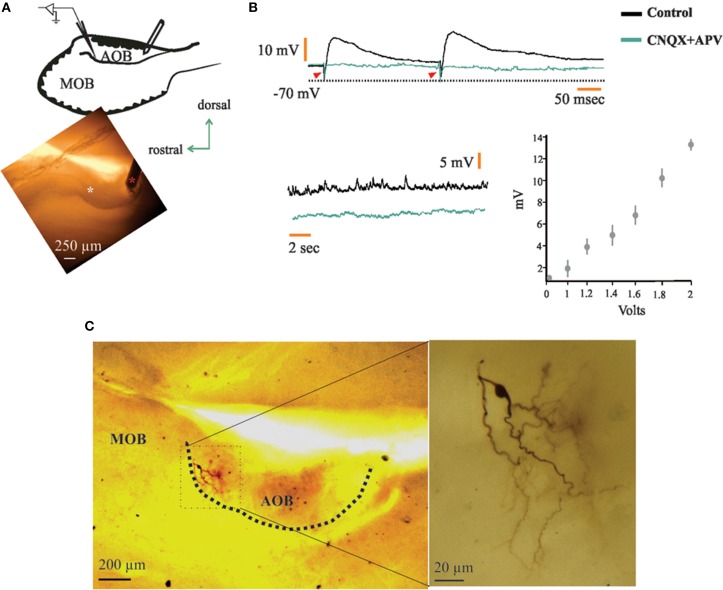
Neurons in the anterior half of the accessory olfactory bulb (aAOB) receive synaptic input from posterior half (pAOB) neurons. (A) Schematic of the recording setup (left) and picture taken the day the neuron in c was recorded (red asterisk, stimulating electrode; white asterisk, tip of recording electrode). (B) Top: upon pAOB paired-pulse stimulation, neurons (n = 6) responded with excitatory postsynaptic potentials (EPSPs) that were completely abolished in the presence of CNQX and APV (20 μM; arrowheads indicate stimulating artifact). Bottom: spontaneous EPSPs before and after CNQX and APV incubation (left) and plot showing EPSP response amplitude vs. stimulus intensity (right; n = 6). (C) Picture of the neuron at low (left) and high (right) magnifications, note the very anterior position of the cell recorded (top left), which has a morphology resembling that of a short-axon neuron.